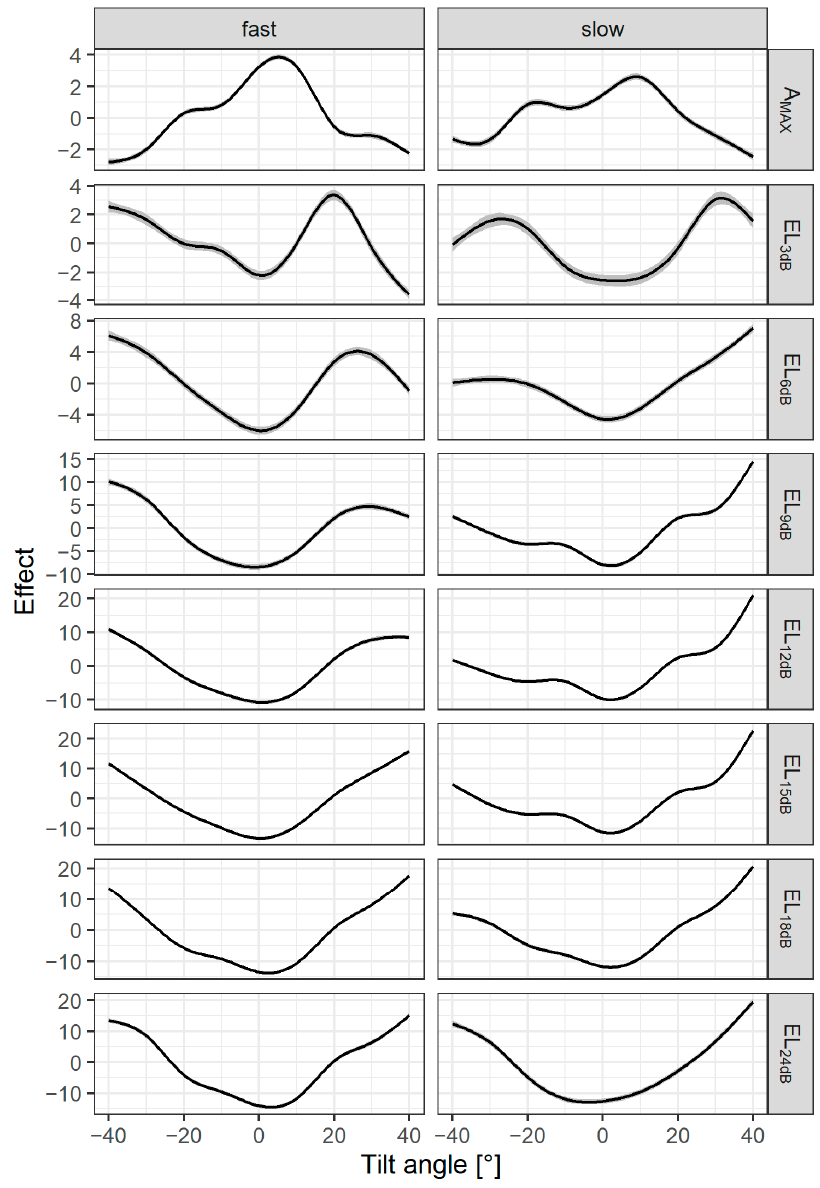
Figure 4. Effect of the fish tilt angle (0 ◦ correlates to the true dorsal aspect; negative angles correlate to the head tilted toward the transducer; positive angles correlate to the tail tilted toward the transducer) on the amplitude echo descriptors in the fitted generalized additive mixed models (GAMM) for fast- and slow-tapered broadband acoustic pulses. A black line represents a smooth component (function of one variable) implemented as a thin-plate spline, with a gray area representing a 95% confidence interval. A MAX stands for the amplitude maximum. EL stands for the echo length at several levels, expressed as the number of decibels below A MAX (dB; labeled as a subscript). Note the different y -axis scales.